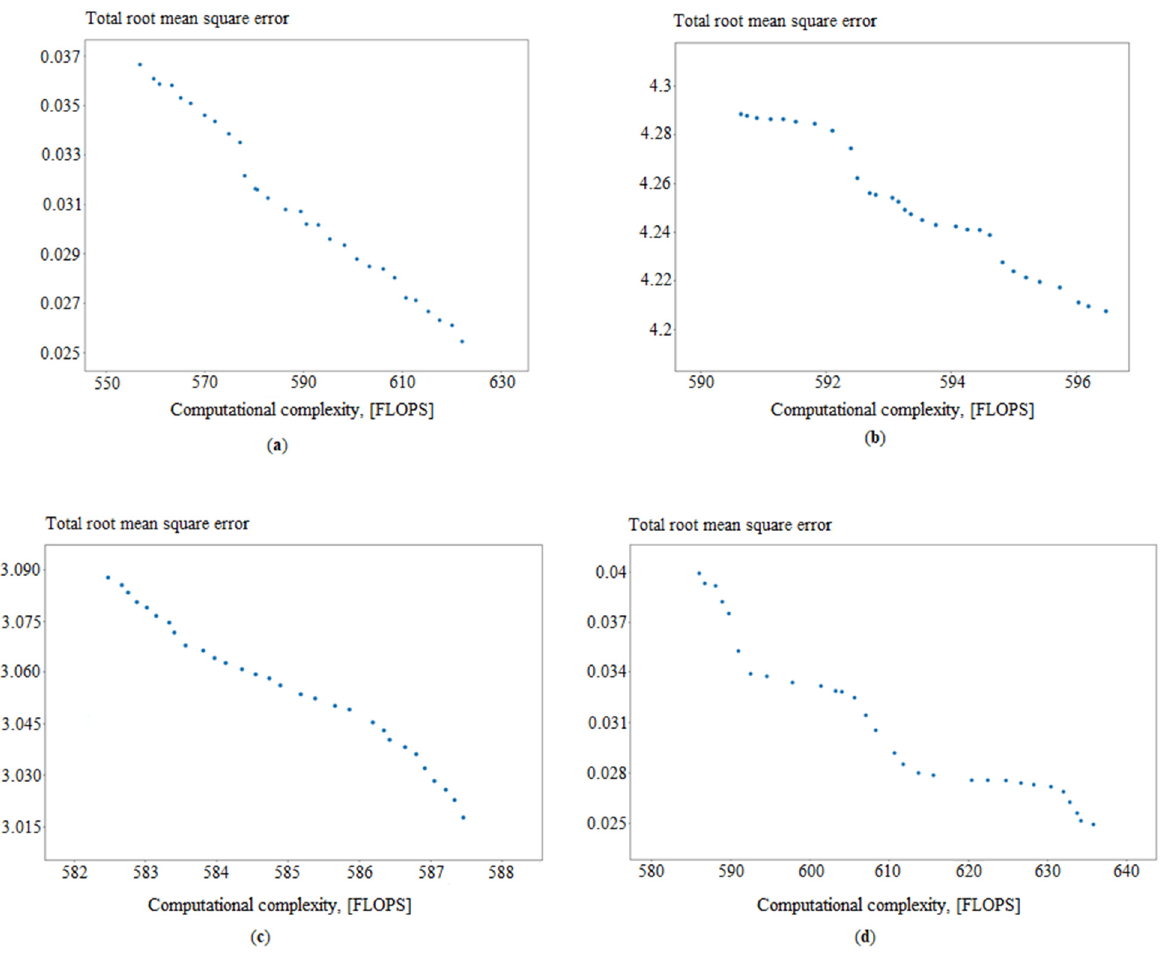
Figure 11. Approximations of the Pareto-optimal front on the last generation in determining the best from, where ( a ) ANN ident , ( b ) ANN corr , ( c ) ANN predict , and ( d ) ANN control .